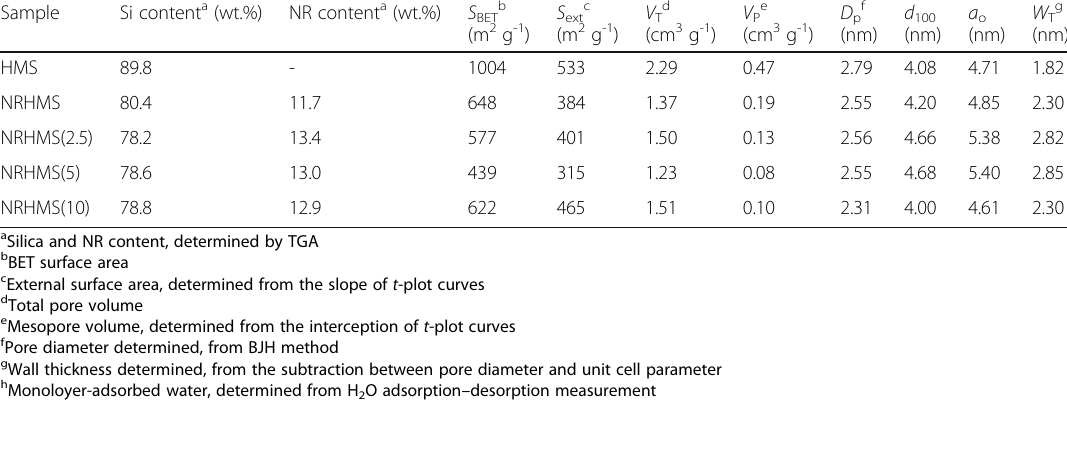
Table 1 Physicochemical properties of the HMS and NRHMS nanocomposites Sample Si content a